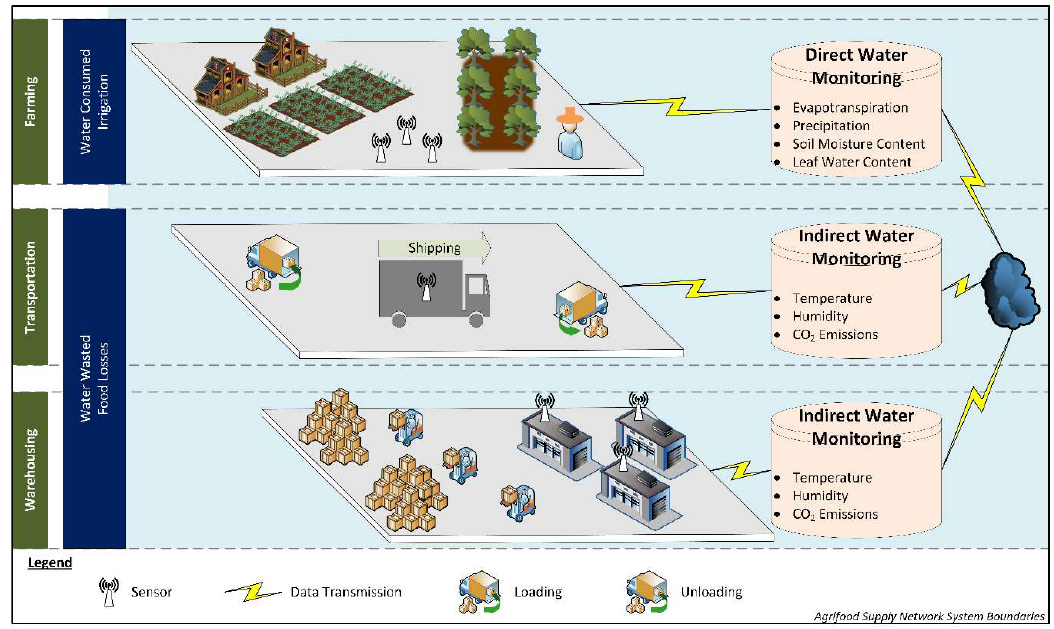
Figure 1. Sensor-based system for water monitoring in agrifood sytems.